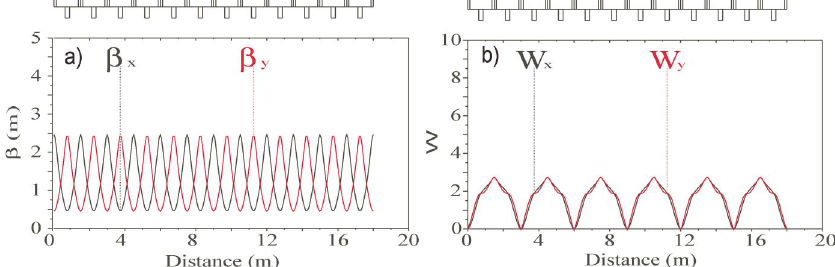
(cid:1) (cid:6) 5 : 3 (only 12 out 16 FODO cells are actually shown): (a) beta functions, (b) chromatic r